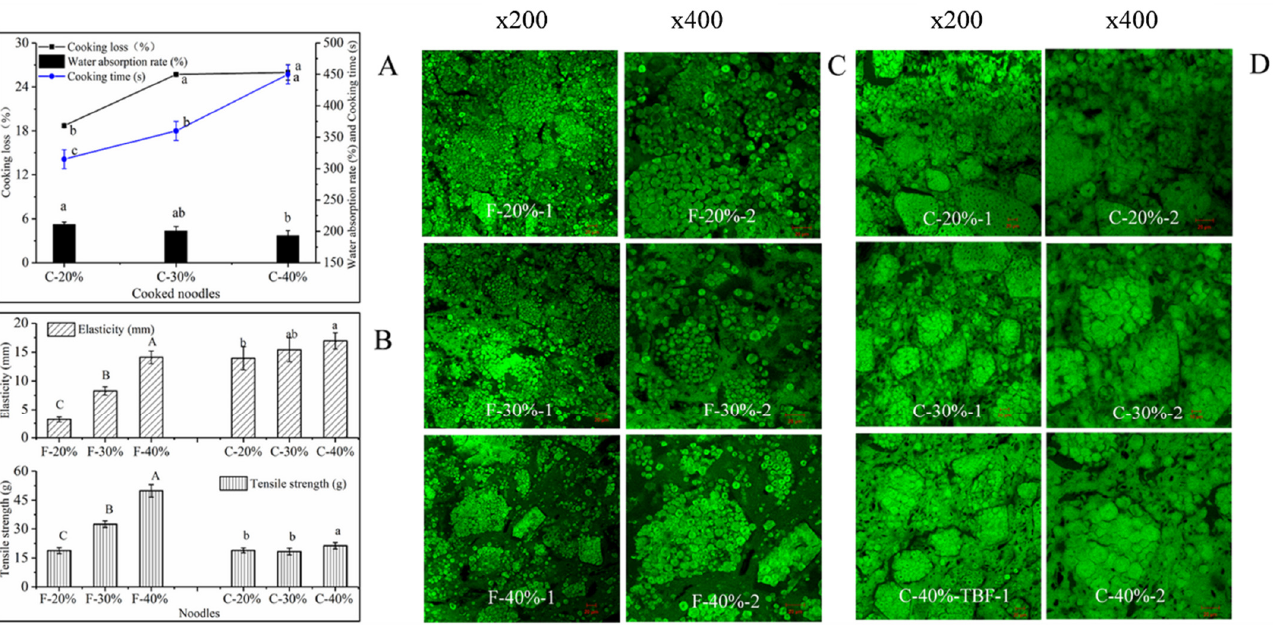
Figure 4. The cooking properties of noodles ( A ), tensile properties ( B ), and microstructure ( C , D ) of the fresh and cooked noodles. Different letters (uppercase and lowercase) in the same group represent significant differences ( p < 0.05). F, C, and TBF represent fresh noodles, cooked noodles, and Tartary buckwheat flour, respectively. The 20%, 30%, and 40% represent the addition level of ES in the noodles.